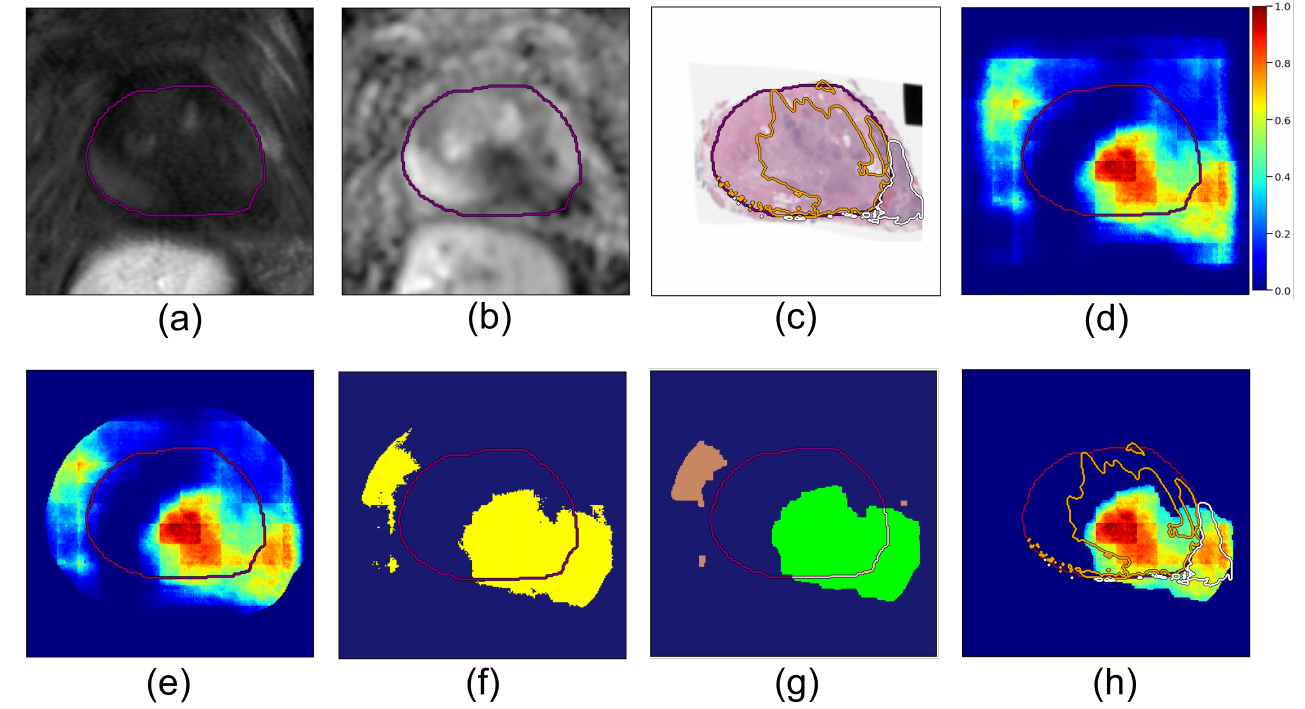
Figure 2. Row 1: Registered MRI and histopathology slices, along with output from cancer detection deep learning model in a patient with bulky extraprostatic extension. ( a ) T2w image, ( b ) ADC image, ( c ) Histopathology image overlaid with ground truth cancer labels and prostate segmentation mask. Purple contour shows prostate gland segmentation, orange contour is cancer inside the prostate, white contour is extraprostatic extension (EPE). ( d ) Cancer probability map output by the pre-trained deep learning cancer detection model. Row 2: Post-processing steps to generate final predictions for cancer with extraprostatic extension. ( e ) Cancer probability map after applying dilated prostate mask. ( f ) Candidate lesions (shown in yellow) were obtained by applying binary threshold and detecting connected components. ( g ) Candidate lesions were pruned based on their location relative to the prostate; components fully inside or fully outside the prostate were rejected (brown), those crossing the border were accepted (green). For the green lesion candidate, the tumor-capsule contact line (TCL) is displayed in pink. ( h ) Final prediction map for lesion with